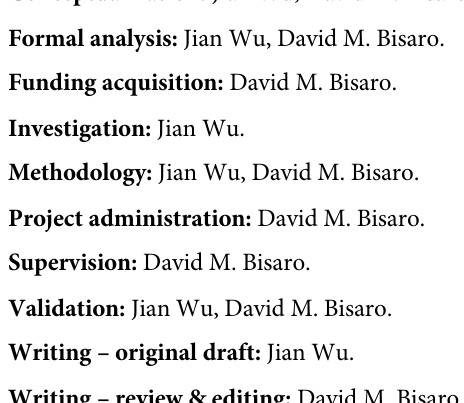
S7 Fig. Confirmation of TMV infection in Nb plants. Nb plants rub-inoculated with WT PSTVd, 76AU, or 156AU were agroinfiltrated at 3 dpi with a pCB301 vector expressing TMV or GUS (negative control) at 3 dpi. (A) Nb+TMV and Nb+GUS (negative control) plants (eight per treatment, noted in Fig 6B) were monitored for symptoms of TMV at 10, 20 and 23 dpi (7, 17 and 20 days after agroinfiltration). TMV infected plants experienced lethal necrosis by 23 days. (B) TMV infection in inoculated leaves of plants presented in Fig 6B was confirmed by RT-PCR amplification of CP sequence at 10 dpi with actin as an endogenous control. P, positive control. M, mock. S8 Fig. Infectivity of PSTVd WT, 76AU, and 156AU in Nb plants with TMV infection at 10 dpi; RNA blot analysis. (A) Local infection assay at 10 dpi. Rub-inoculated leaves of the same Nb+TMV and Nb+GUS plants noted in Fig 6B were collected and RNA samples analyzed for PSTVd accumulation by RNA blot. (B) Systemic infection assay at 10 dpi. Upper leaves from the same plants were collected at 10 dpi and analyzed for PSTVd accumulation. Numbers indi- cate the 8 plants included in each group and those in red indicate plants with positive PSTVd signal. P, positive control. M, mock. PSTVd-C, circular form of PSTVd. Loading control was ribosomal RNA. S9 Fig. Systemic infection of PSTVd WT, 76AU, and 156AU in Nb plants with TMV infec- tion at 10 and 20 dpi; RT-PCR analysis. RNA samples isolated from rub-inoculated leaves of the same Nb+TMV and Nb+GUS plants noted in Fig 6B were subjected to RT-PCR to detect PSTVd. Systemic infection by PSTVd was detected at 10 (A) and 20 (B) dpi with actin as an endogenous control. PSTVd-C, circular form of